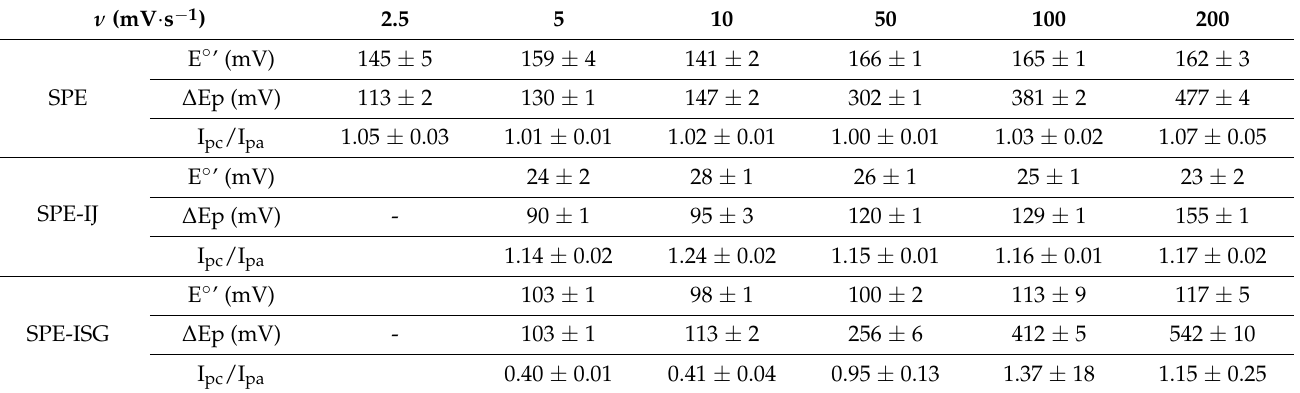
Table 1. Formal reduction potentials, peak separation and ratio of the anodic and cathodic current peaks as a function of scan rate for the Fe(CN) 63 − /Fe(CN) 64 − redox couple in SPE, SPE-IJ and SPE- ISG. Values are averages of the data obtained from all 3 cycles, and respective standard